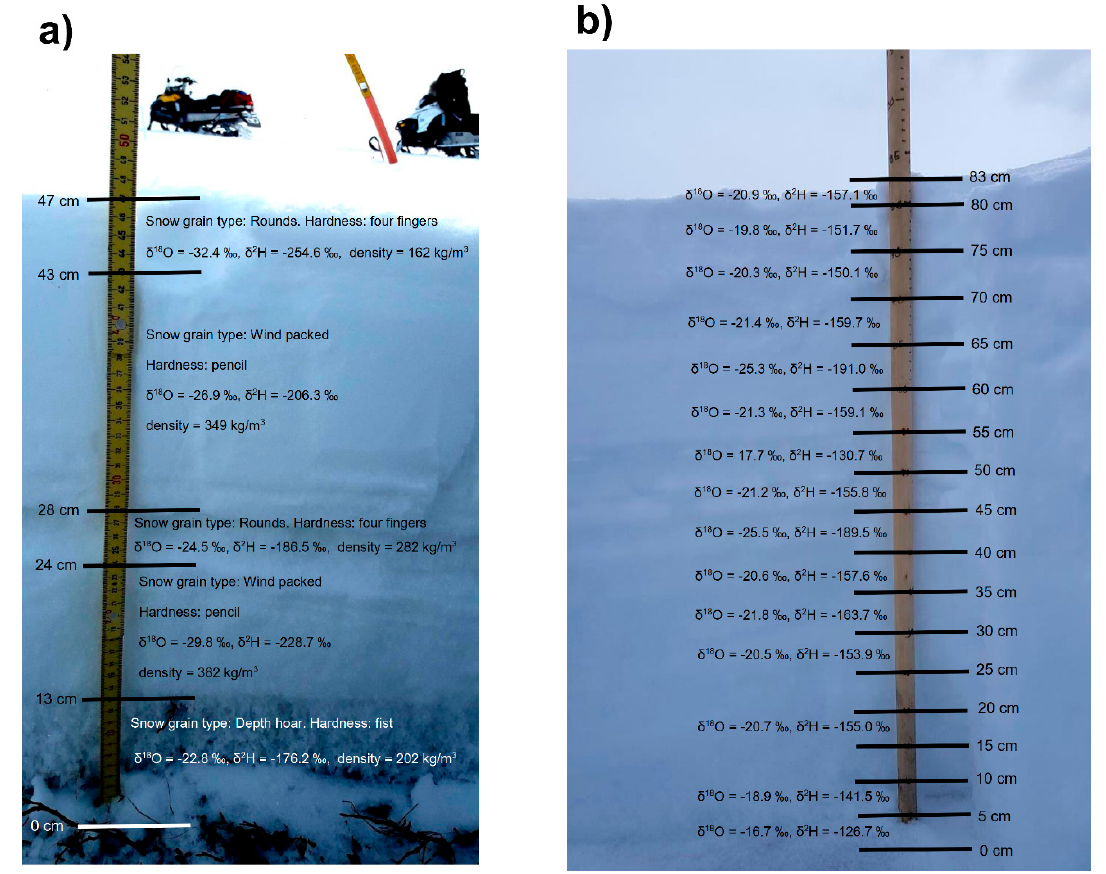
Figure A7. Snow pit stratigraphy and sampling intervals with associated isotope values at ( a ) Imnavait pit three and ( b ) Pallas pit six (see Figure 1). For the Imnavait hand hardness test, snow grain type and snow density data are also presented.